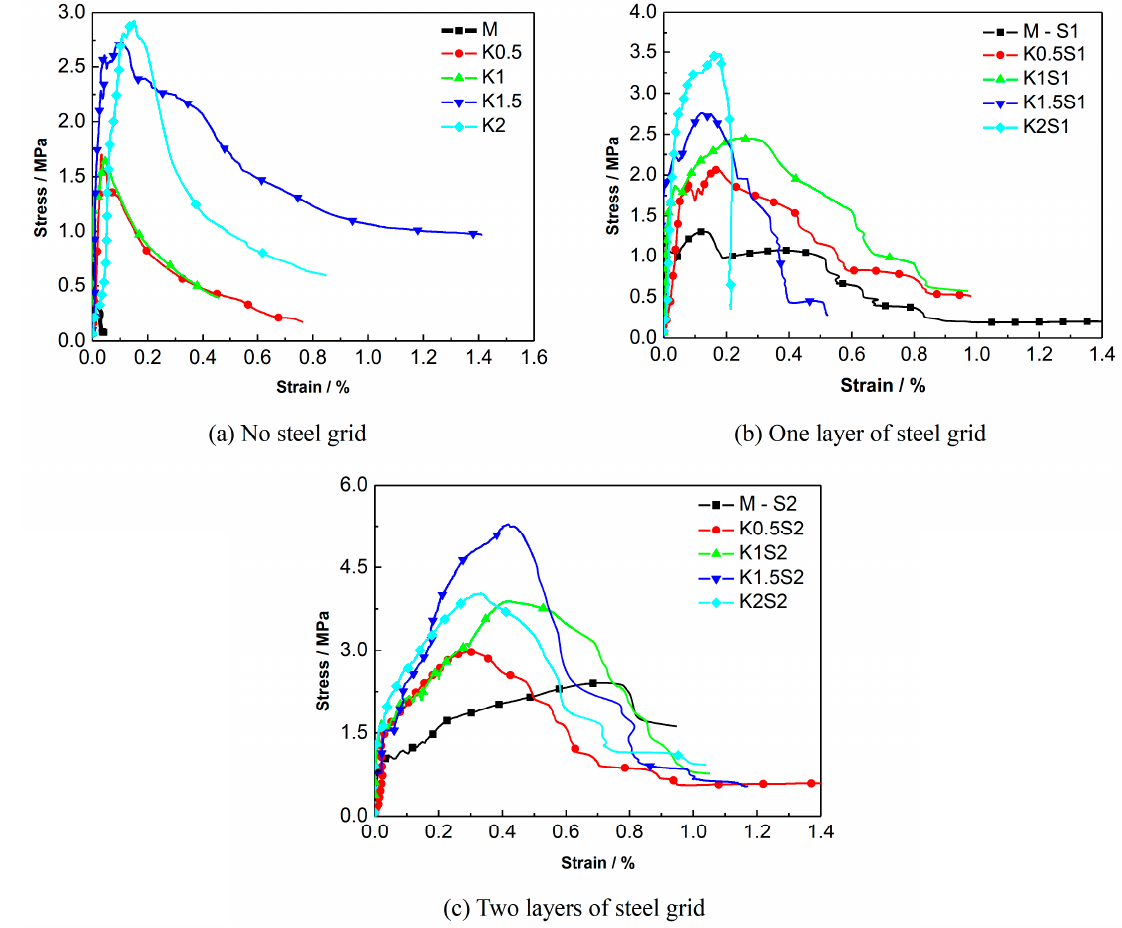
Figure 10. Comparison of stress-strain curves of ECC specimens with di ff erent KEVLAR fiber volume fractions. ( a ) No steel grid; ( b ) One layer of steel grid; ( c ) Two layers of steel